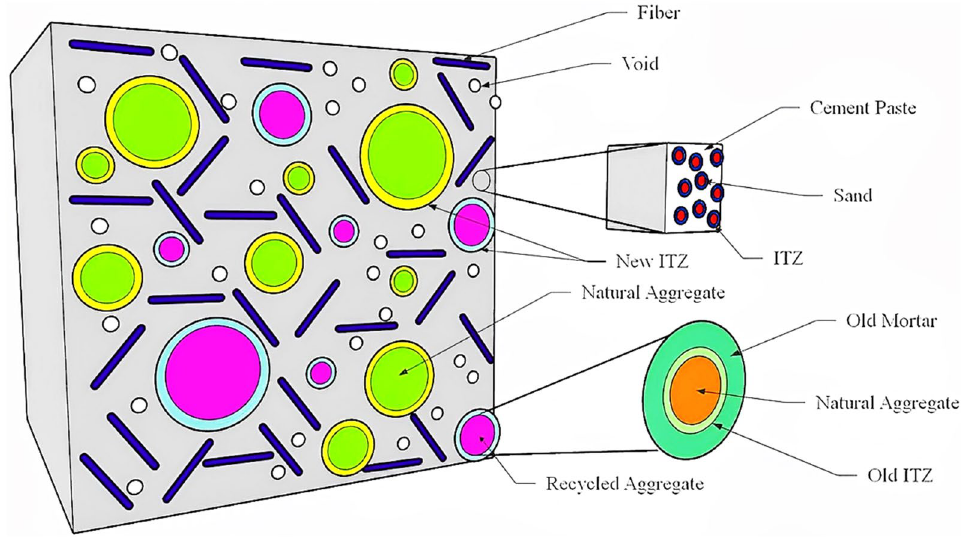
Figure 1. Schematic of FRRAC model.